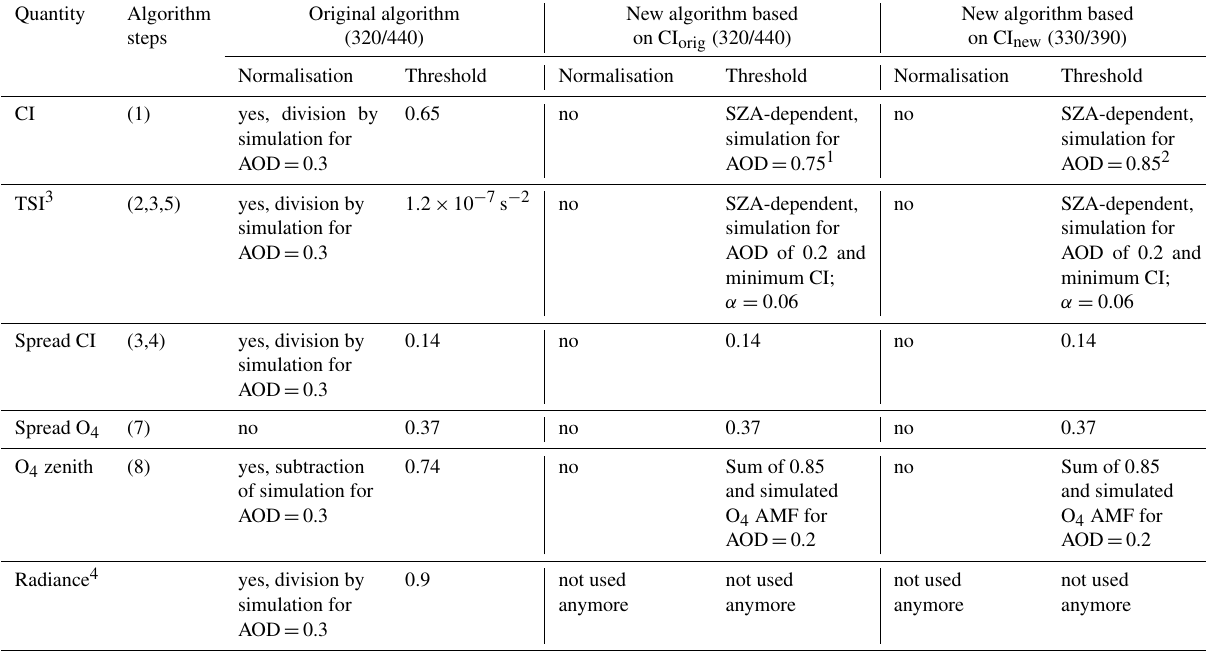
Table 1. Comparison of the normalisation procedures and threshold values for the individual decisions of the cloud classification scheme of the original algorithm and the new algorithms (for CI orig and CI new ). In the column “algorithm steps” it is indicated in which decisions the selected quantity is involved (see Fig.